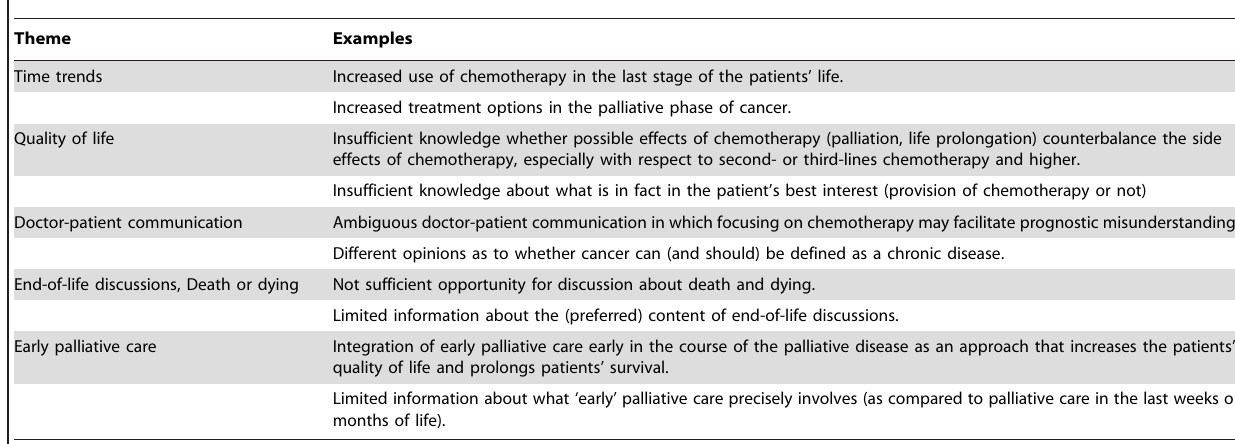
Table 1. Study themes common to the debate of burdensome treatment at the end of life.